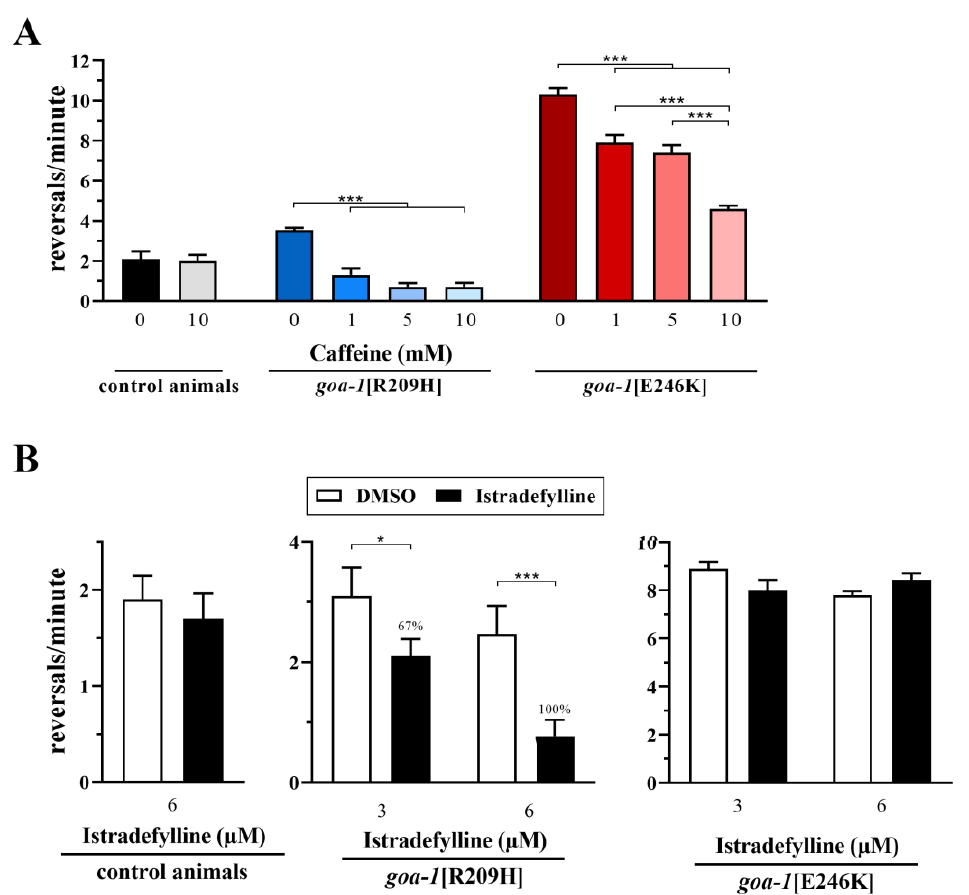
Figure 5. Caffeine and istradefylline variably improve the aberrant locomotor behavior of goa-1 mutants. ( A ) Two hours of exposure to caffeine ameliorated the hyperactive locomotion of knock- in animals in terms of the number of short reversals per minute in a dose-dependent manner (*** p < 0.0001; one-way ANOVA with Bonferroni correction). ( B ) Exposure to istradefylline (2 h) decreased the reversal rate of goa-1 [R209H] worms (* p < 0.05 and *** p < 0.0001) but not goa-1 [E246K] animals, suggesting that caffeine also acts through an AR-independent mechanism. Results are also provided as the percentage of rescue (see Materials and Methods for details). Twenty animals for each genotype were tested. Data represent the means ± SEM of multiple observations.